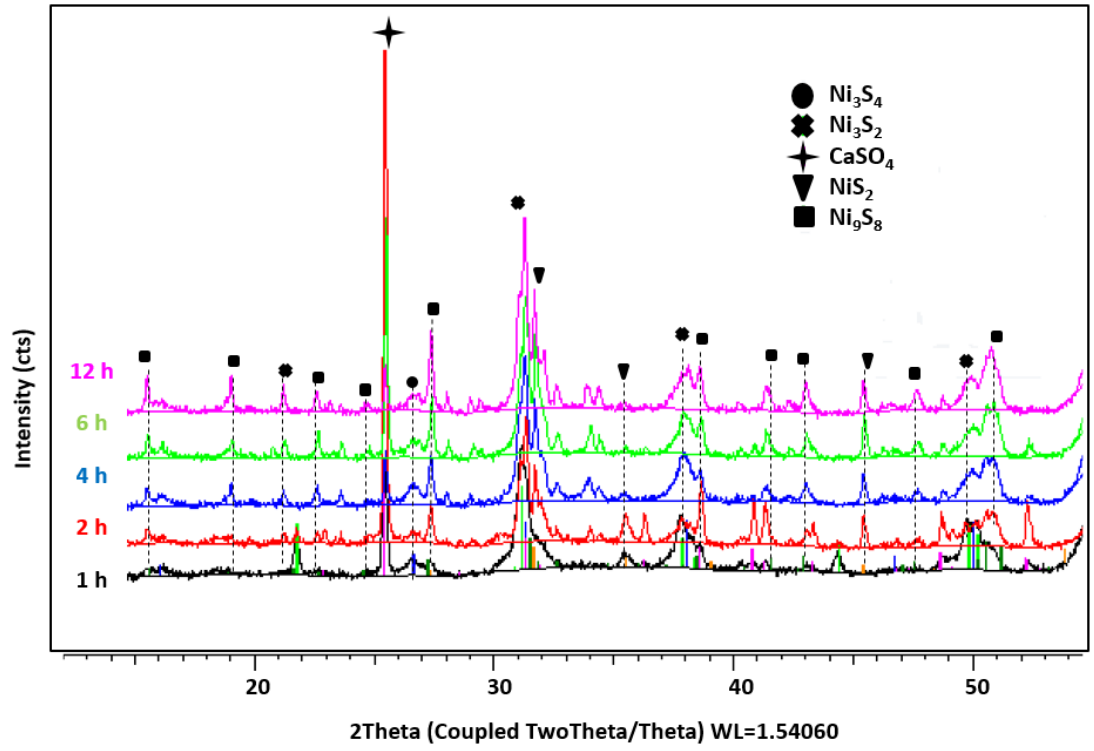
Figure 1. XRD patterns of isolated Ni-based catalyst samples after thermo-catalytic treatment for different duration.